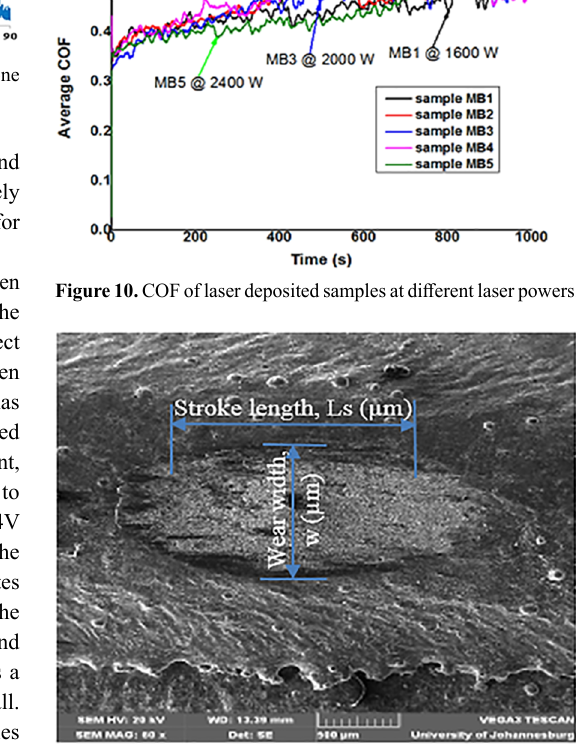
Figure 11. SEM micrograph of a wear scar showing both wear width and stroke